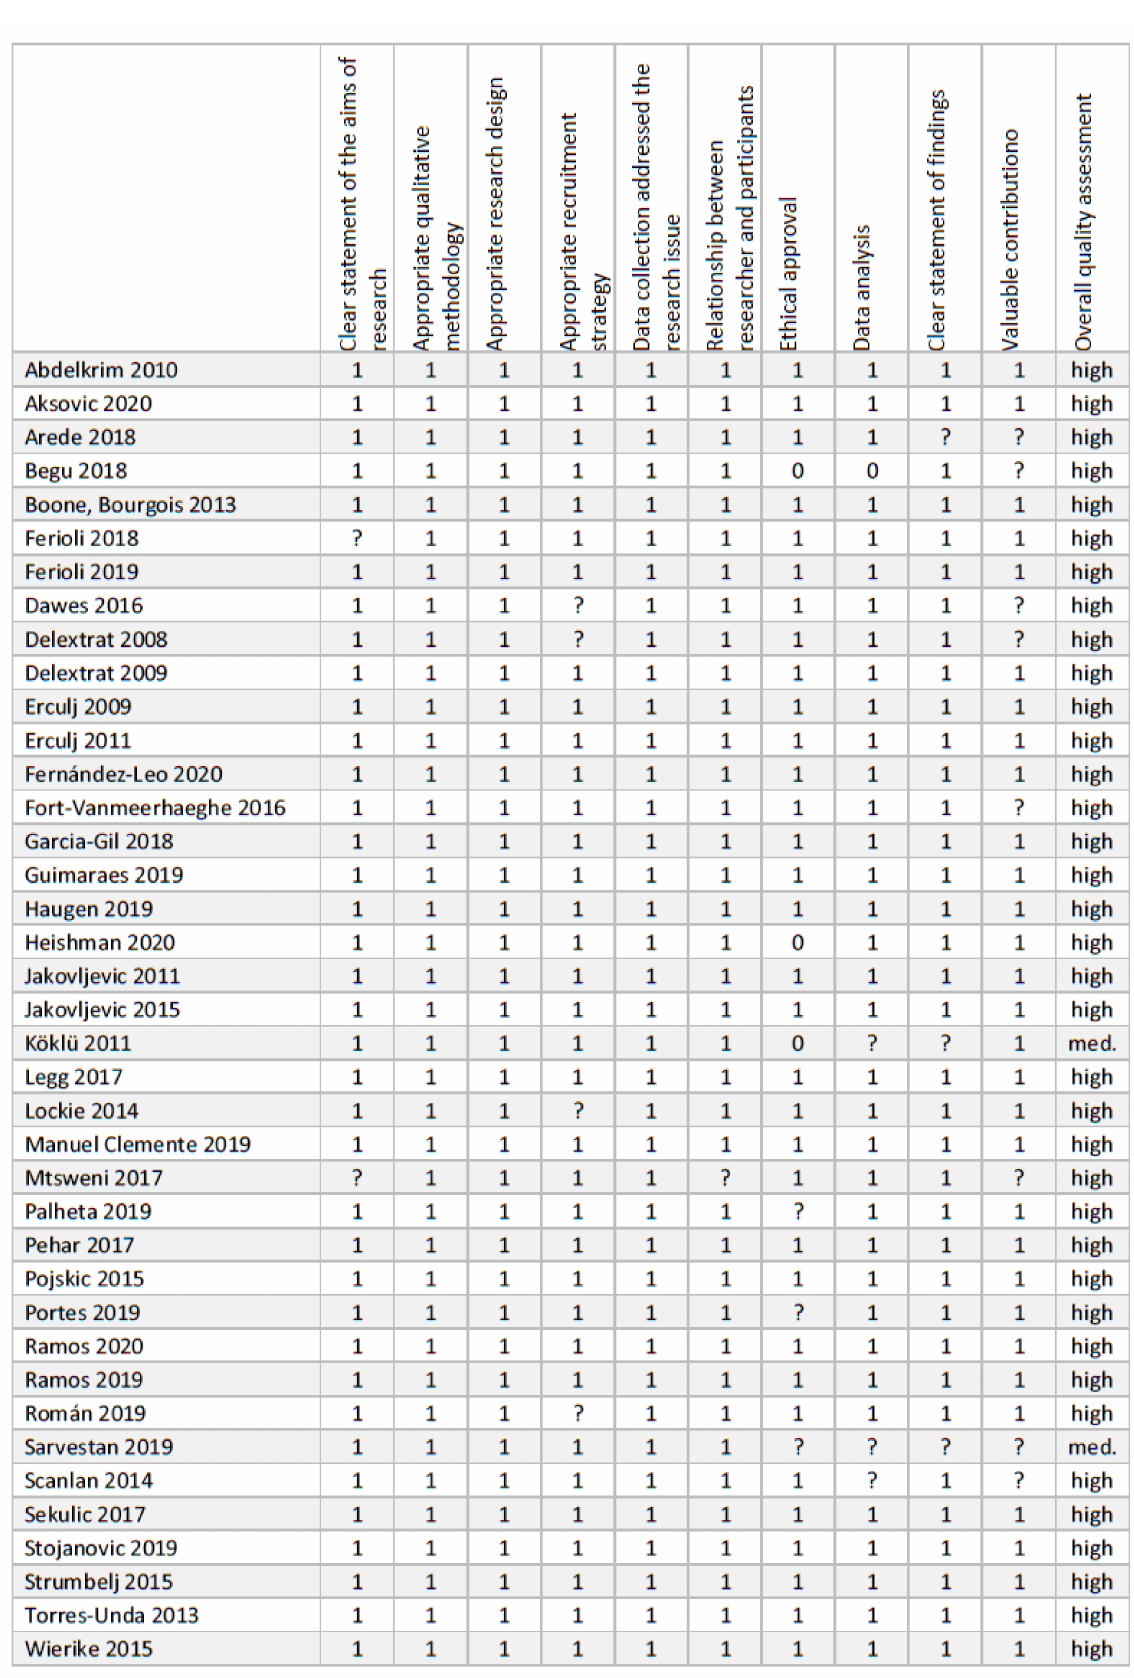
Figure 2. Results of quality assessment for each included article. 1: acceptable; ?: unclear risk of bias; 0: